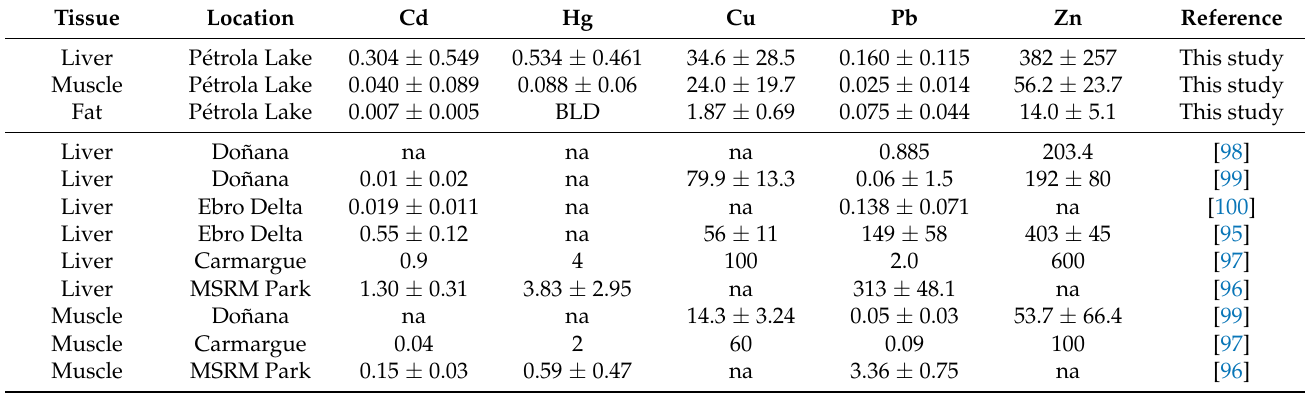
Table 2. Mean ( ± SD) concentrations of heavy metals in collected in Phoenicopterus roseus samples (mg/kg dry weight), and comparison with other locations. BLD: below the limit of detection; na: not